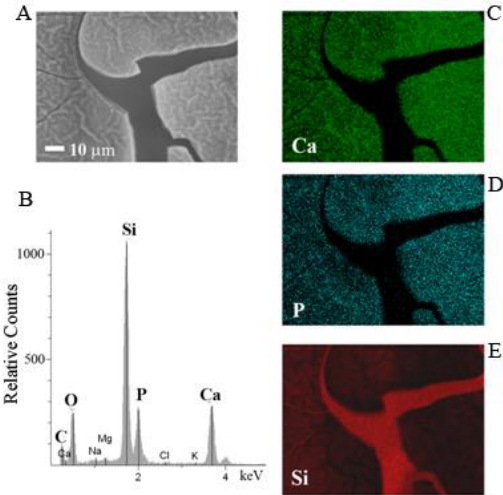
Figure 5. ( A ) SEM image of biomineralized film deposited by the C9 cells after 14 days in culture on PSS28, clearly showing the ECM fibers. ( B ) EDX spectra of the film showing the presence of Ca, P, O, and Si minerals present. ( C – E ) Elemental maps of Ca, P, and Si on the surface with overlap of Ca and P consistent with a uniform layer of hydroxyapatite incorporated into the ECM fibers shown in ( A ).